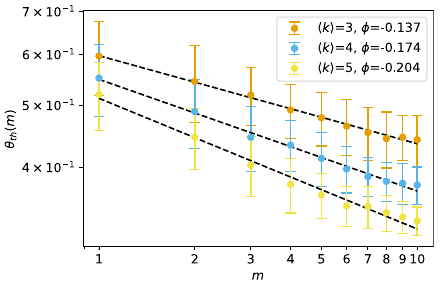
Fig. 7 The speed-up obtained by the Fast ConPT algorithm over star- mesh reduction. The fi gure shows the computing time (in seconds) to calculate C st , the s - t concurrence between two nodes s and t , on 2D square lattices with n nodes using the Fast ConPT method with the S 1 and S 2 approximation, as well as using the star-mesh reduction method of Meng et al. 24 . We can see that the Fast ConPT method speeds up the calculation over the star-mesh transform method by two orders of magnitude.